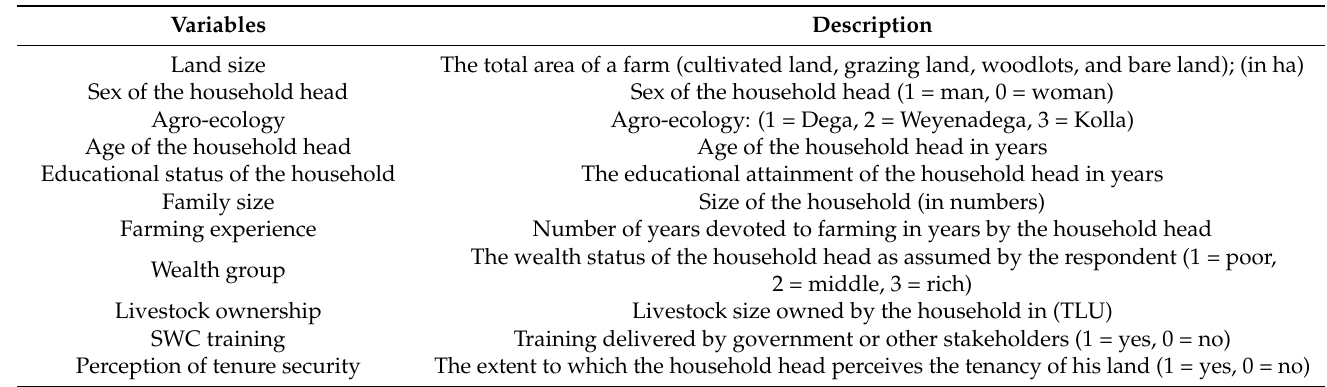
Table 2. Description of independent